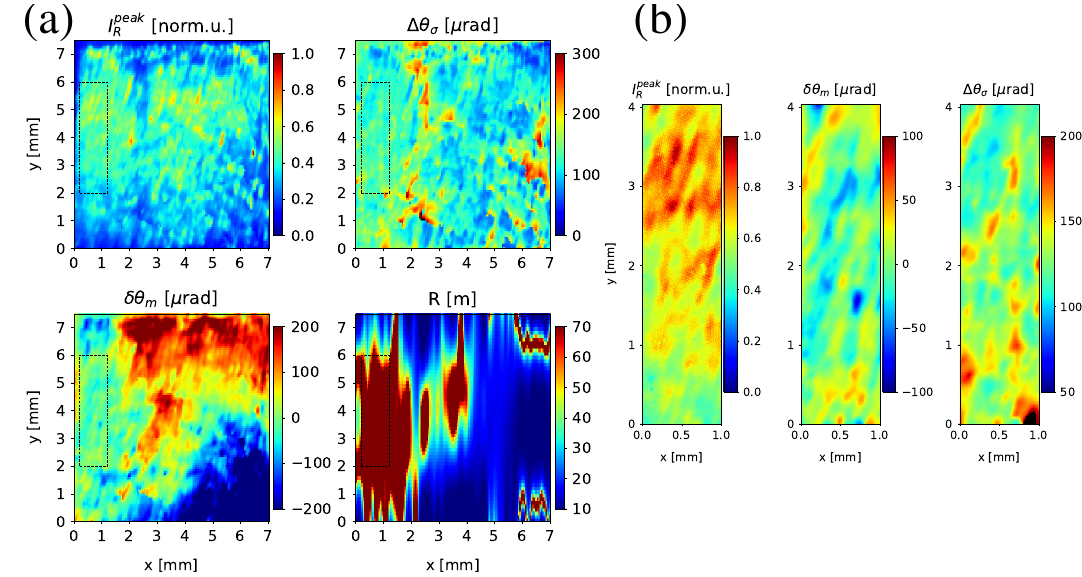
Figure 3. Rocking curve topographs for the (100)-edge oriented diamond crystal plate (CVD-B): ( a ) for the entire crystal showing maps of peak reflectivity ( I peak , normalized by the maximum observed value), R rocking curve peak position ( δθ m ), width ( ∆ θ σ ), and the effective radius of curvature R calculated from spline-interpolated δθ m ; ( b ) for the region of interest where the radius of curvature is maximized R 0 (cid:38) 70 m (shown by the dashed rectangle in ( a )). The x and y coordinates in ( b ) are shown with respect to the lower left corner of the rectangle. The limits of the colormaps for δθ m and ∆ θ σ in ( b ) are redefined to highlight variations in the mapped